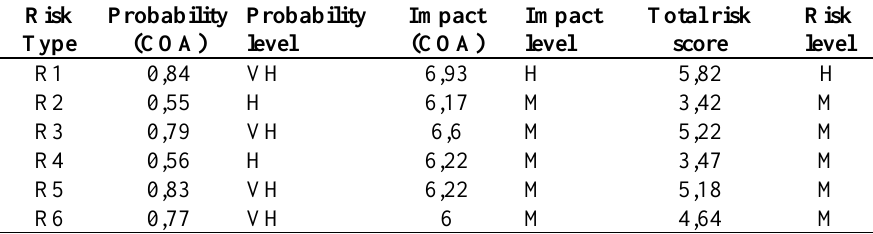
Table 7. Determination of ratings for risk occurrence probability and